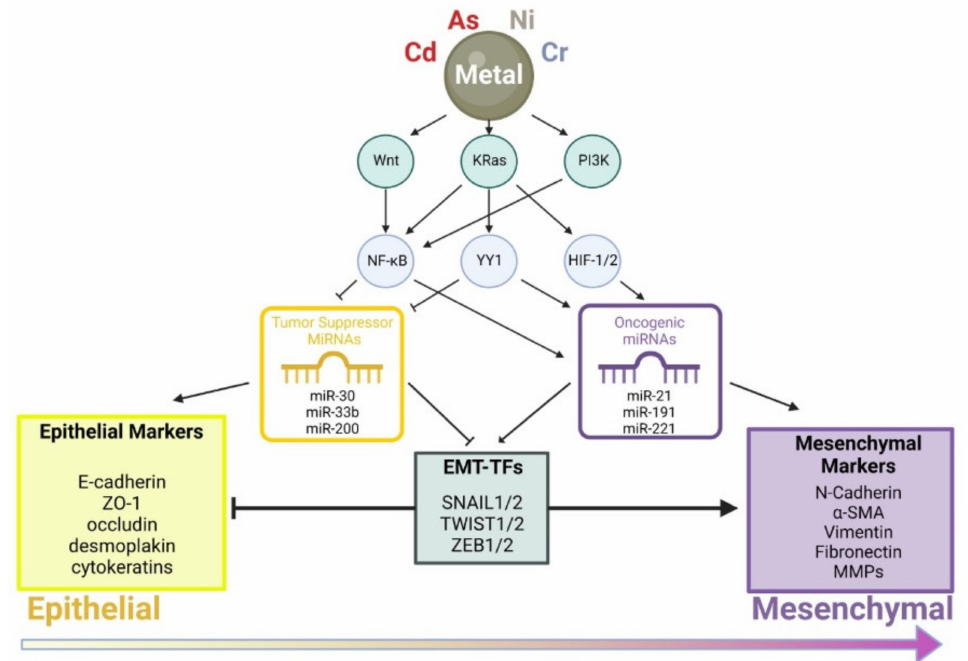
Figure 2. A model depicting modes of action of various toxic metal(loid)s in promoting the epithelial– mesenchymal